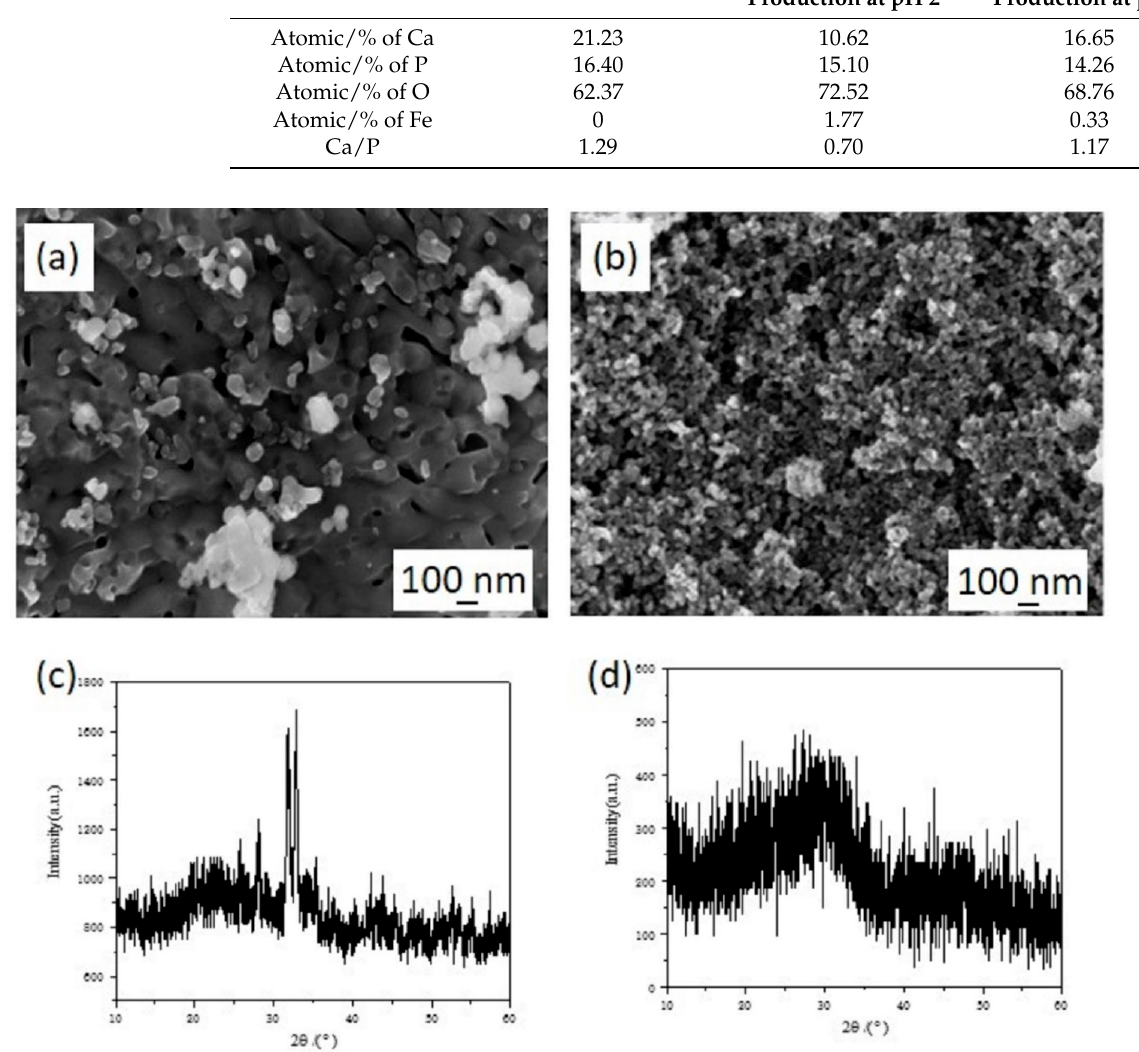
Figure 4. The SEM micrographs and XRD patterns of the reaction solid production of Fe(III) transfor- mation in presence of HAP at reaction time t = 10 min ( a , c ) and t = 2 h ( b , d ).